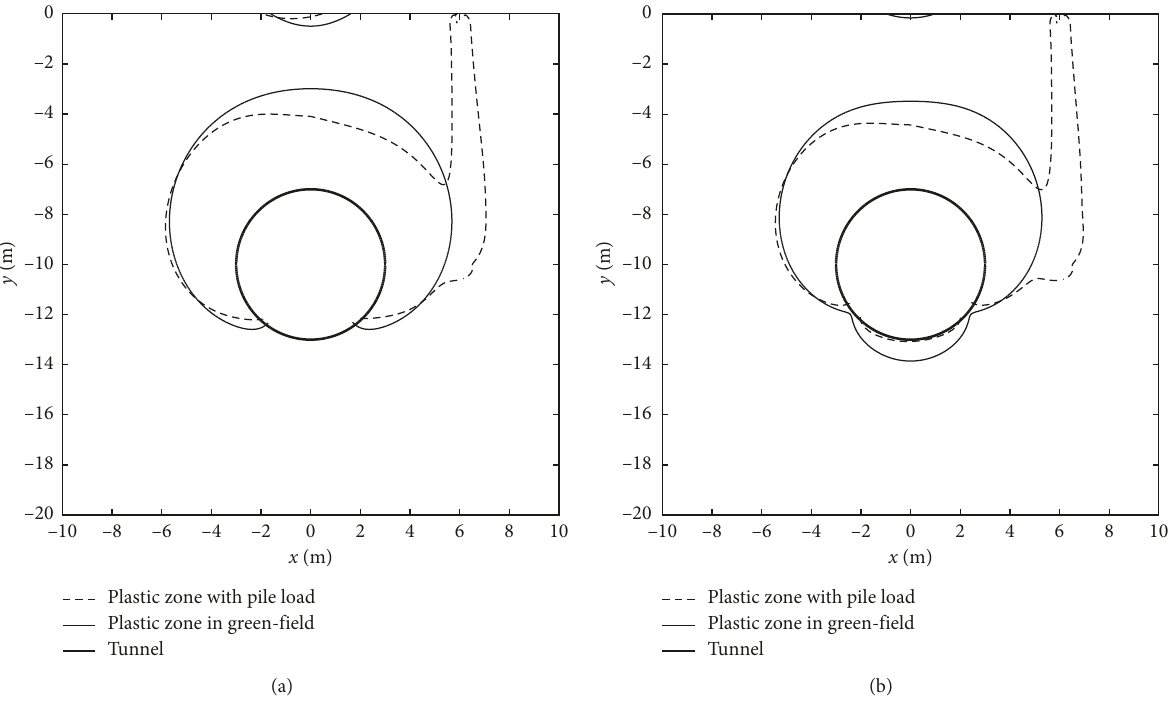
Figure 6: Envelopes of potential plastic zones for different tunnel boundary conditions. (a) B.C.-3 [10]; (b) B.C.-4